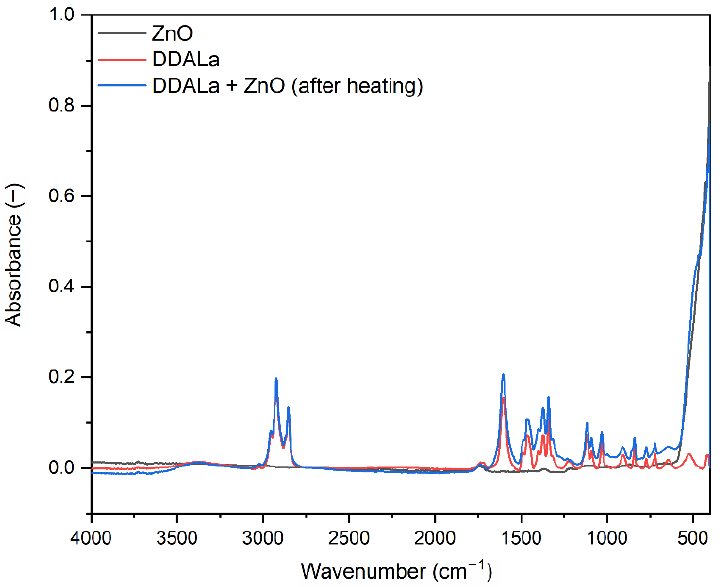
Figure 4. FTIR spectra for ZnO and DDALa mixture after heating at 70 °C for 30 min.